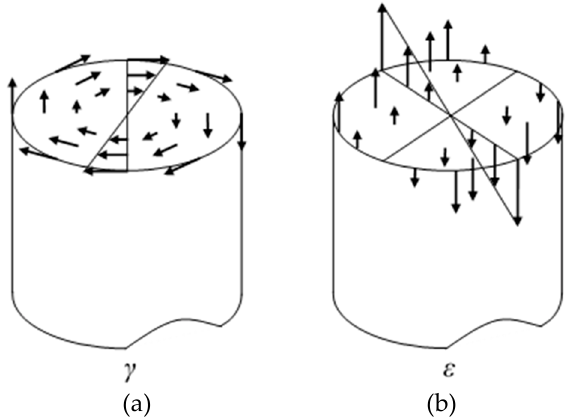
Figure 4. Schematic of the distributions of the shear strain γ and normal strain ε on the cross section of wire for ( a ) shear strain and ( b ) normal strain.